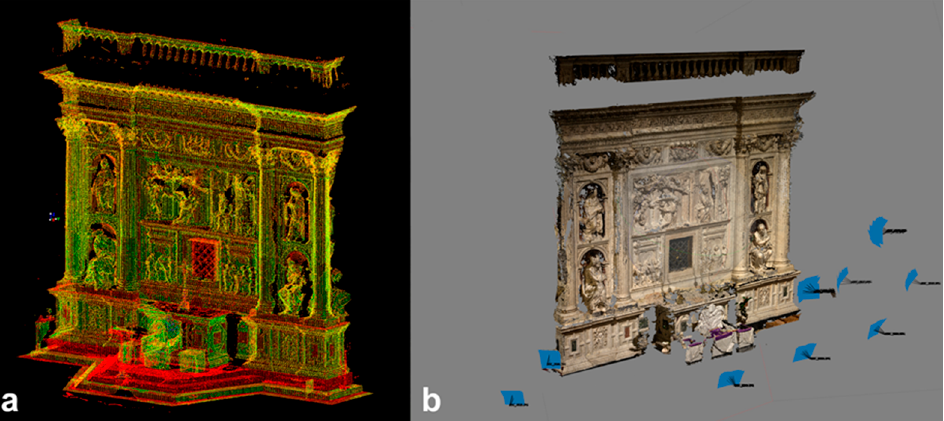
Figure 2. The digital survey of the sculpted panel of the Annunciation: ( a ) the laser scanner point cloud; ( b ) the point cloud resulting from photogrammetric processing of the